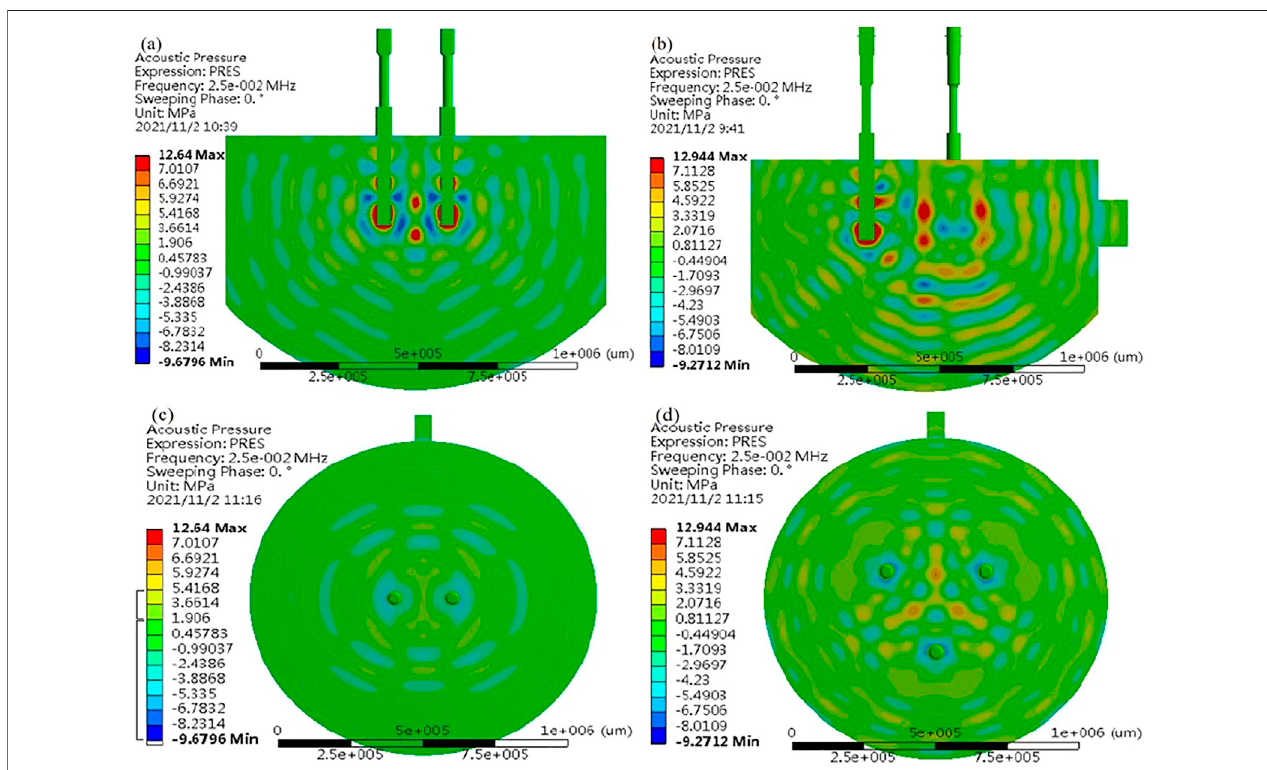
FIGURE 6 | Sound pressure simulation distribution diagram: (A) sound pressure distribution of the DSU-treated ingot, (B) sound pressure distribution of the TSU-treated ingot, (C) the top view of the DSU-treated ingot, and (D) the top view of the TSU-treated ingot.